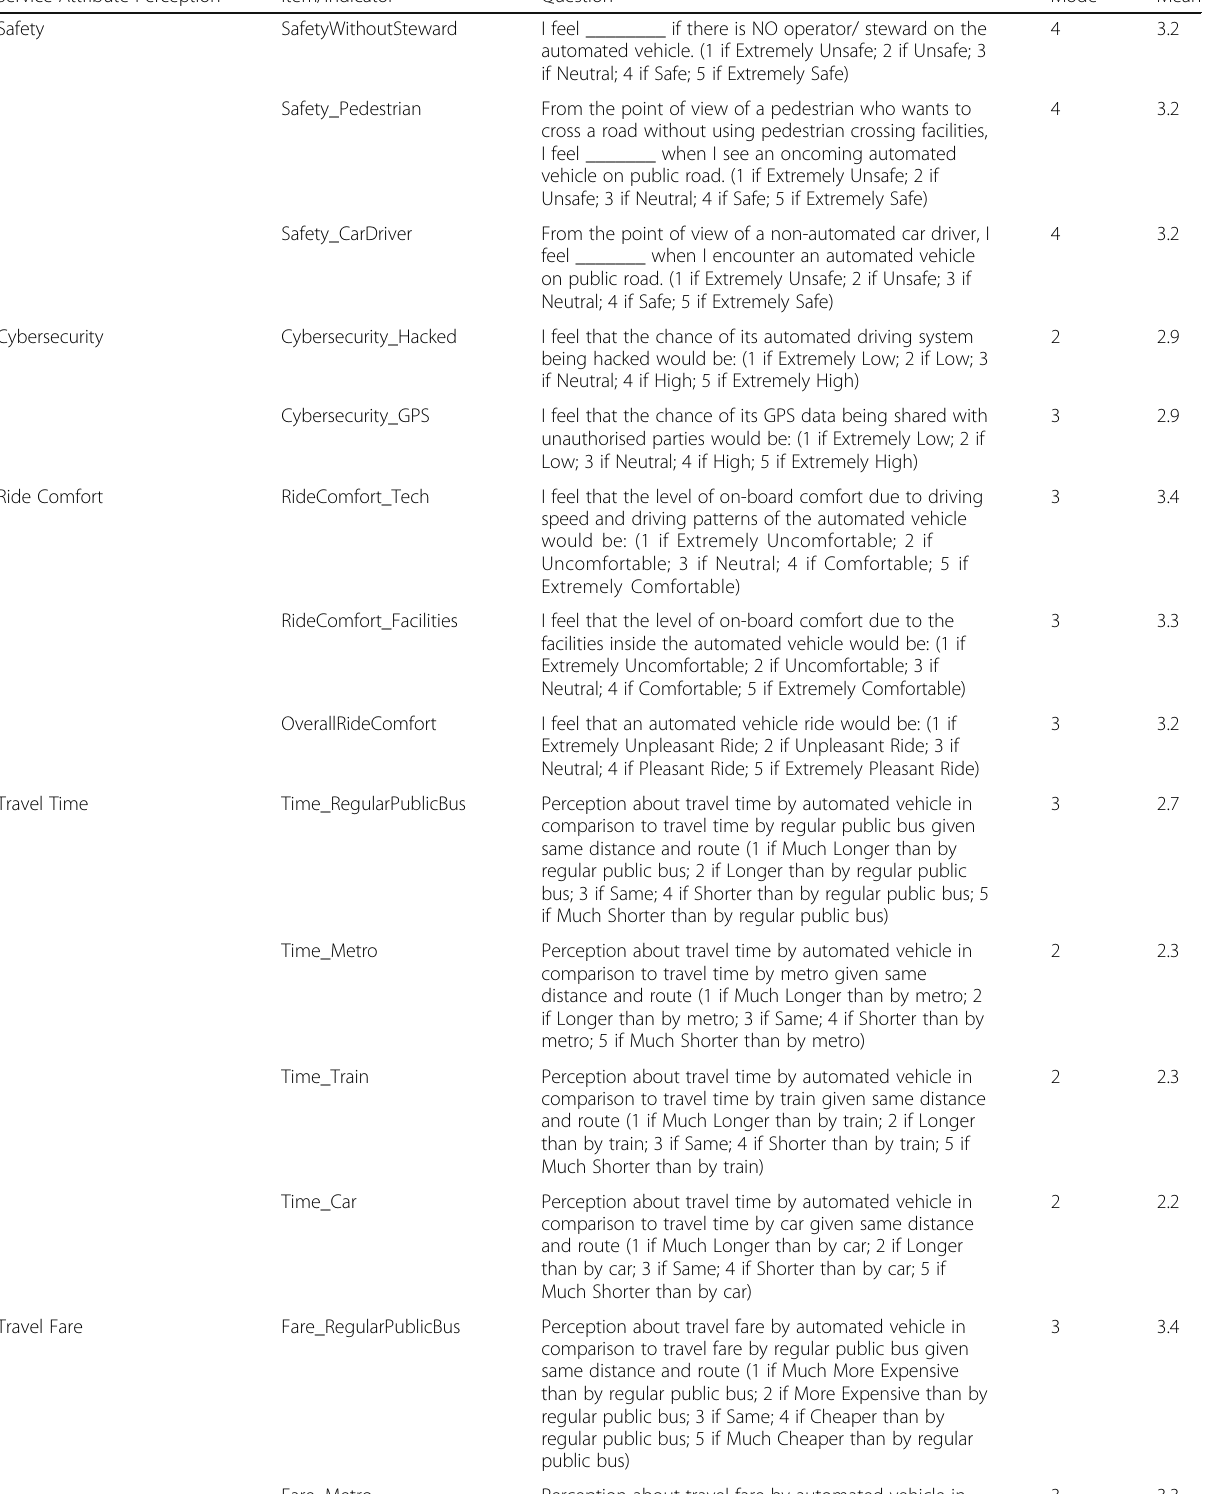
Table 2 Items/indicators for service attribute perception Service Attribute